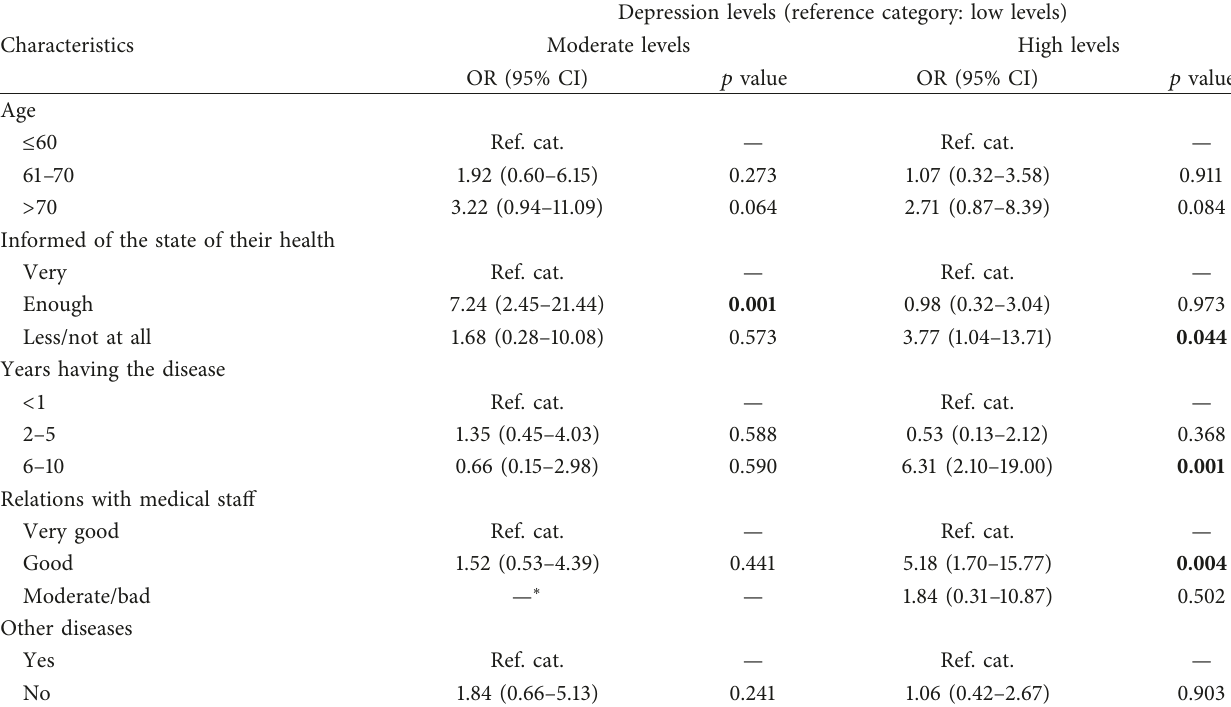
Table 6: Effect of patients’ characteristics on the levels of